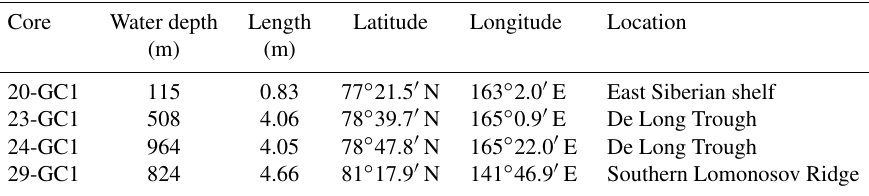
Table 2. Locations, lengths, and water depths of the cores studied. Data from O’Regan et al. (2017) and the SWERUS cruise report (The SWERUS Scientific Party,